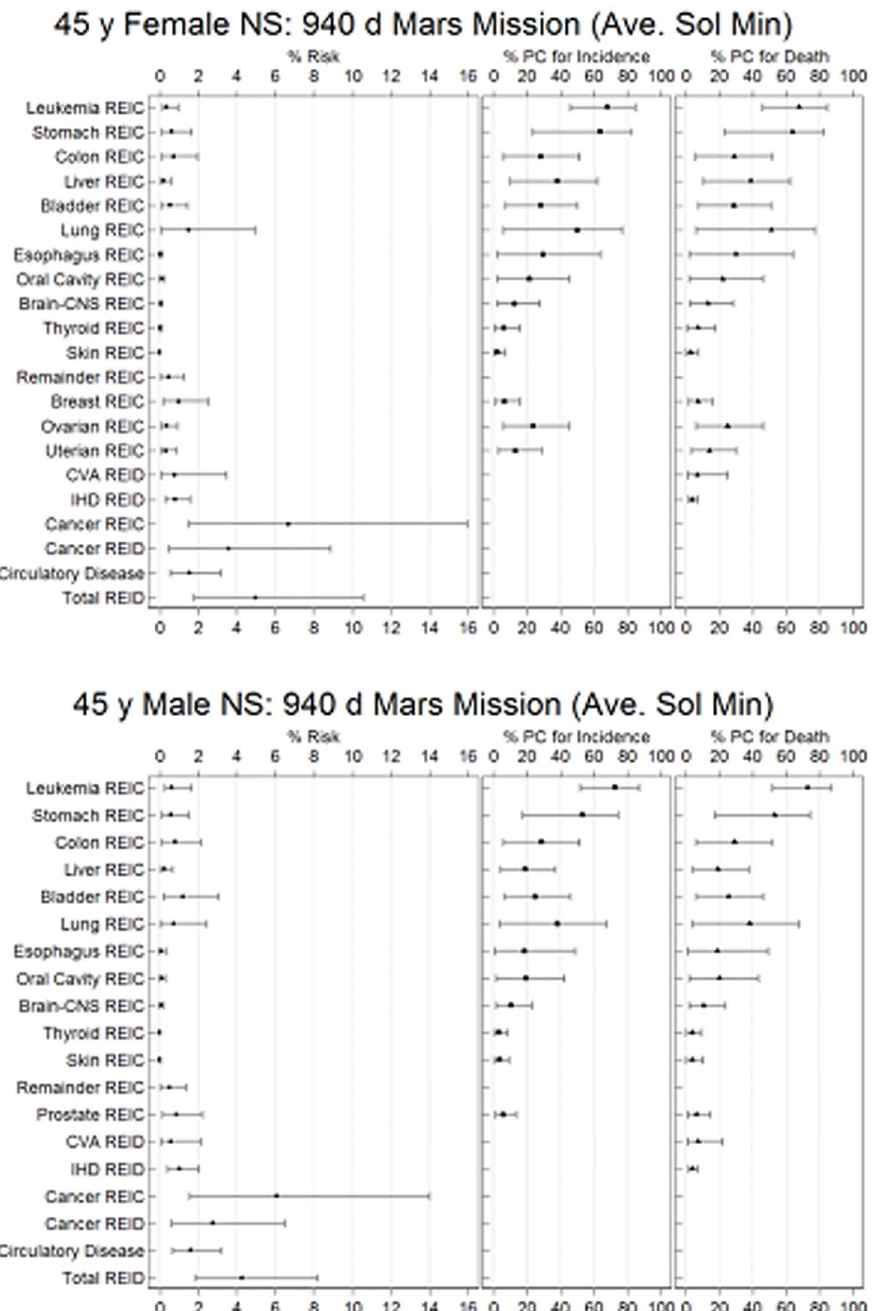
Figure 4. Estimates of tissue specific %REIC, %PC for incidence and death and %REIC and %REID for 940-d Mars mission with average solar minimum conditions. (A) Values are for an average 45-y female never smokers and (B) for an average 45-y male never smokers. Calculations assume 20 g/cm 2 and 10 g/cm 2 aluminum shielding for transit and martian surface, respectively. PC estimations are for 20 years post mission. All point assessments are bracketed by 95% confidence